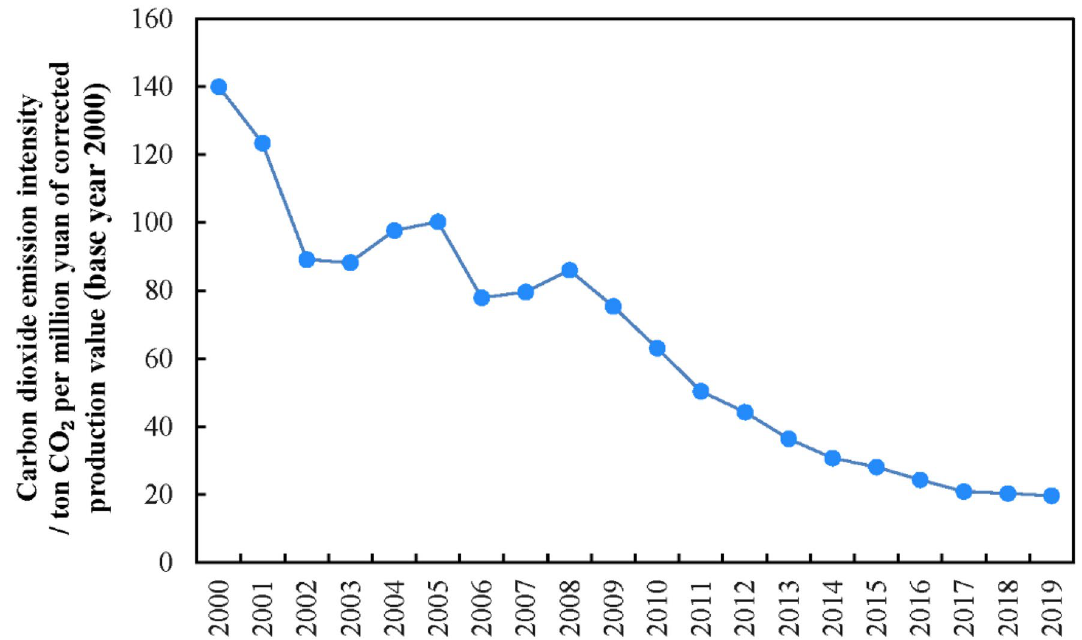
Fig. 5 CO 2 emissions intensity of the wood and bamboo processing industry in China from 2000 to